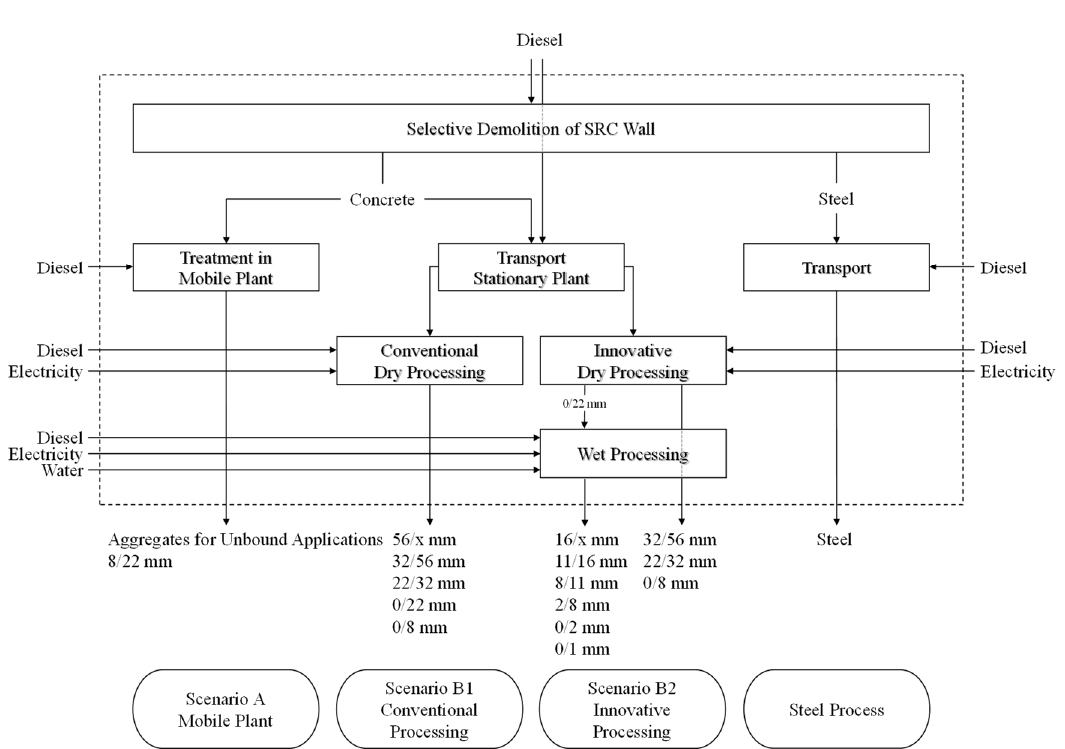
Figure 3. Flow chart: EoL CRC.